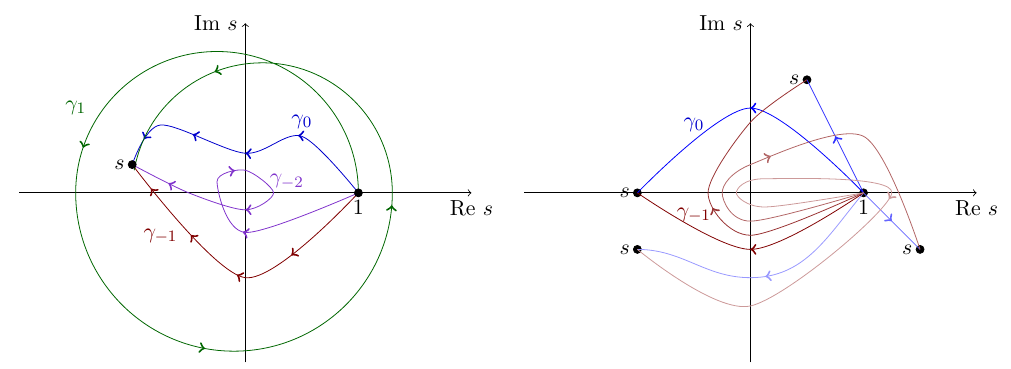
dx , where the x γ s = ln( s + iε ) and 0